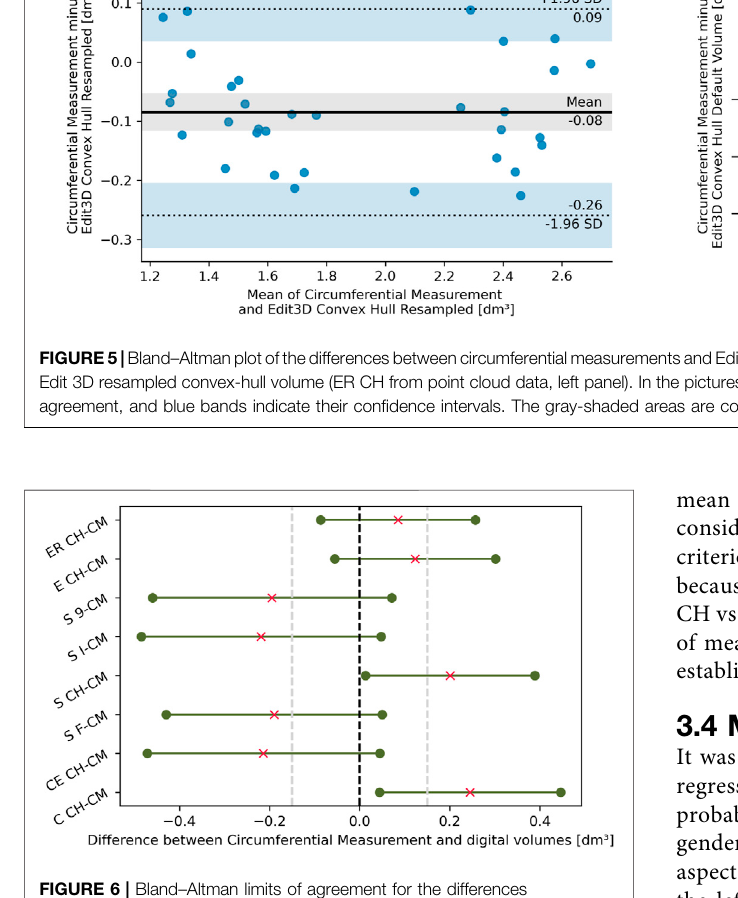
FIGURE 6 | Bland – Altman limits of agreement for the differences betweencircumferentialmeasurementCManddigitalvolumes, withthemean differences as red crosses. Differences between circumferential measurements and Slice 3D non-convex-hull volumes (S 9, S I, and S F) break the normality assumption of the Bland – Altman